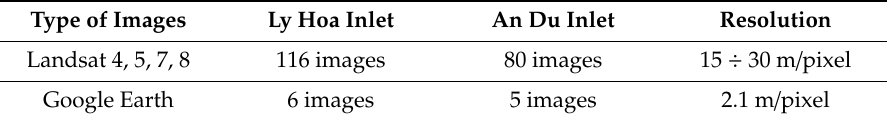
Table 1. A summary of the collected satellite images for the Ly Hoa and An Du study areas.